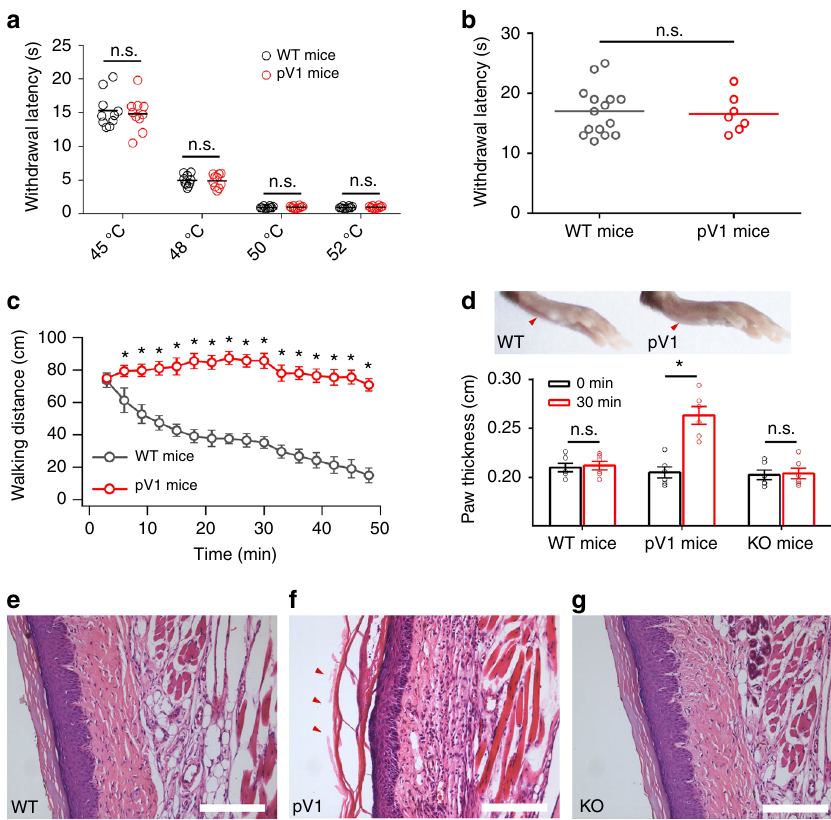
Fig. 5 Dh transition provides a feedback and protective mechanism against scald damages. a , b Withdrawal latencies of female mice in the tail- fl ick ( n = 10, two-sided t -test: n.s., not signi fi cant) ( a ) and hot plate ( n = 15 for WT mice, n = 7 for p- trpv1 mice, two-sided t -test: n.s., not signi fi cant) ( b ) assays. c Walking distance for every 3 min (50 min video-tracking) of female WT ( n = 5) and p- trpv1 ( n = 3) mice in the hot-plate assay, two-sided t -test: * p < 0.01. d Images of the left hind paw after six times of hot-plate assays. Red arrows indicated the phenotype of paw thickness of female mice (inset). the left hind paw sections taken from female WT ( e ), p- trpv1 ( f ), and trpv1 -KO ( g ) mice after hot-plate assays. Note that paw thickness and tissue